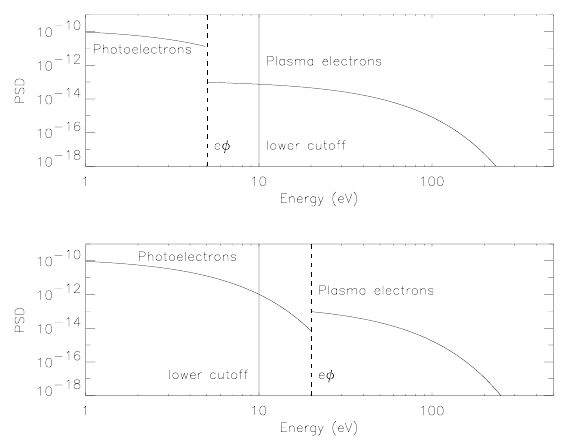
Fig. 2. Electron and photoelectrons distributions for a spacecraft potential smaller than the lower cutoff (upper panel), and for the re- verse situation (bottom panel). The portion of the distribution mea- sured by the detector lies to the right of the solid vertical line.